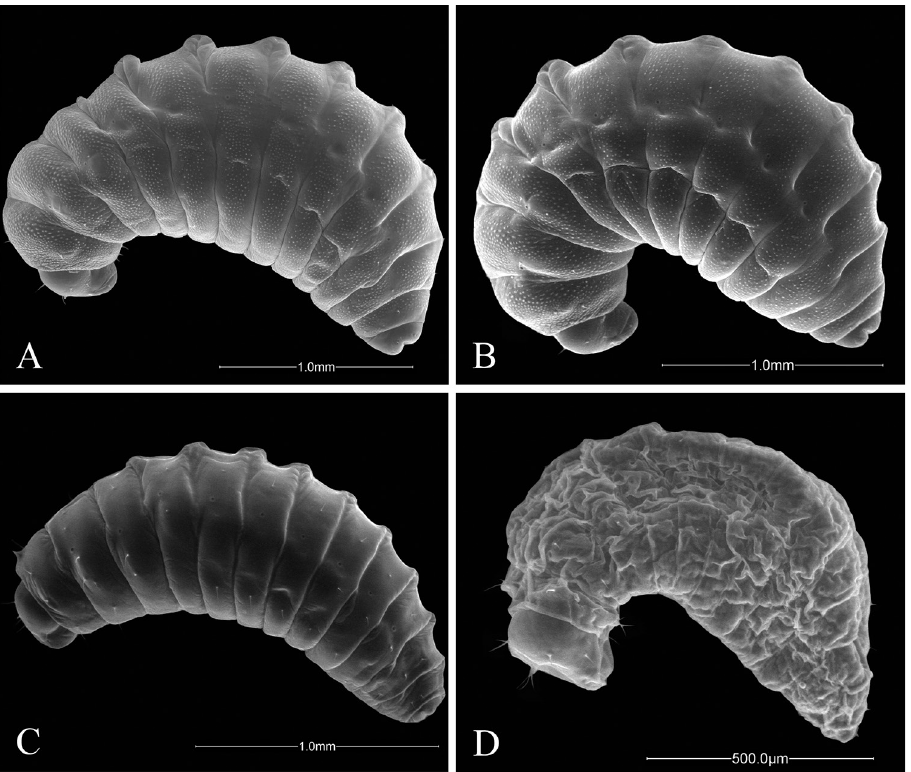
Figure 6. Lateral views of Ormyrus terminal-instar larvae. A O. pomaceus ex Trigonaspis mendesi (Cynipidae) B O. pomaceus ex Plagiotrochus razeti (Cynipidae) C O. rufimanus D O. wachtli